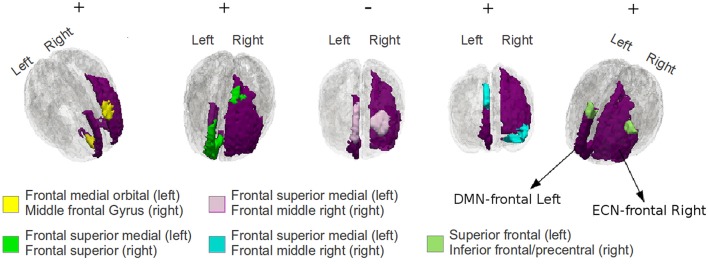
An illustration of the first 5 significantly plastic sub-regional-pairs that were detected by EC based procedure between DMN-frontal left to ECN-frontal right for TBI subject-11; the DMN and the ECN regions have been colored purple. The plastic sub-regional-pairs are colored yellow, green, pink, blue, and light blue (from left to right). The sub-regional-pairs are much smaller than the ROI-pair, and therefore, it may be hard to detect such subtle plasticity effects using a conventional averaging based approach. The +∕−ve signs indicate the plasticity direction.